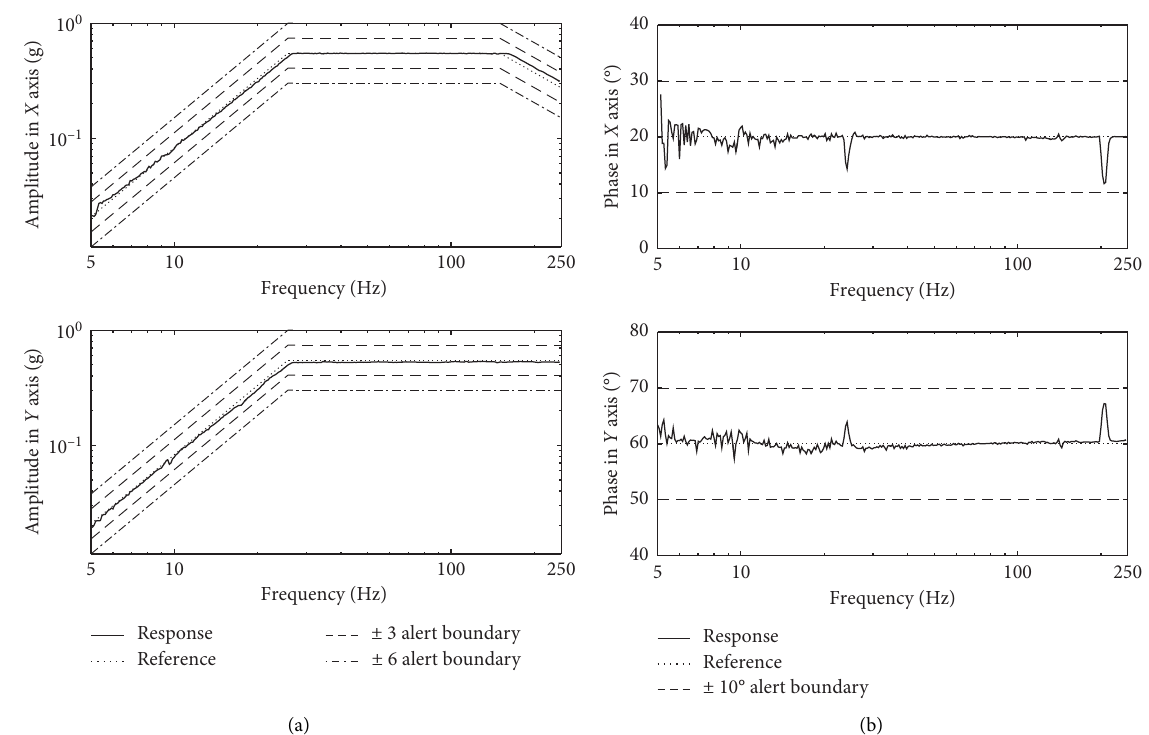
Figure 12: Responses of the lower level ( − 6dB) preliminary test after control (4